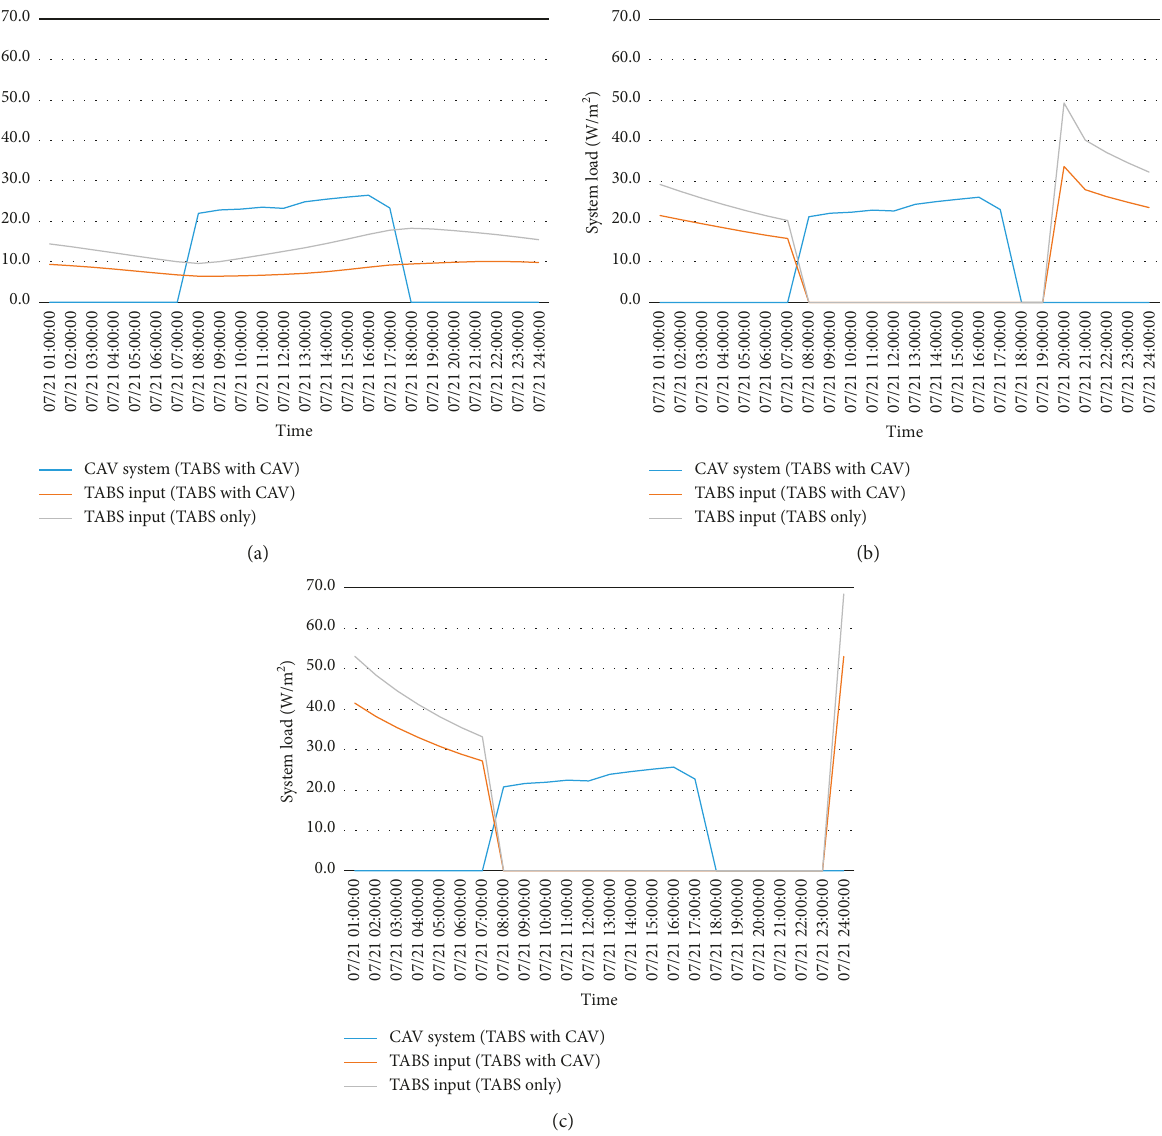
CAV system (TABS with CAV) TABS input (TABS with CAV) TABS input (TABS only)